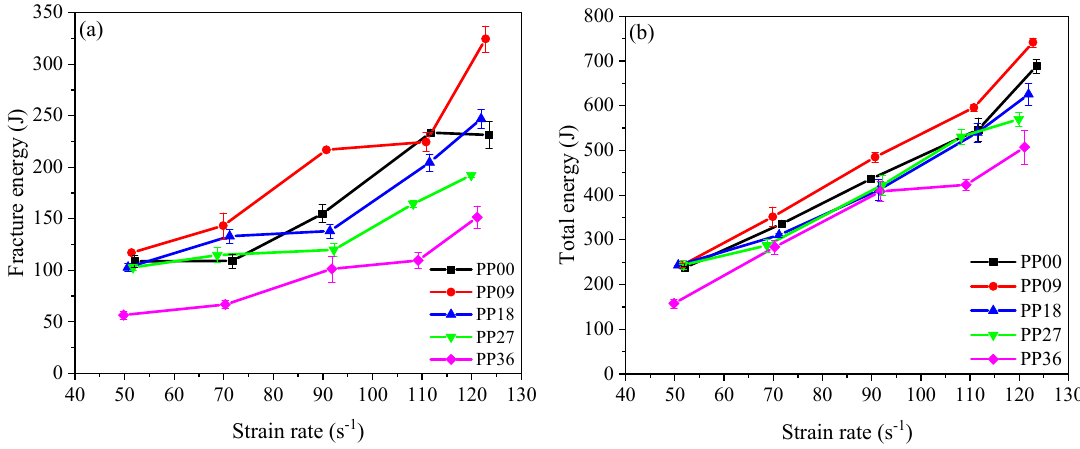
Figure 9. Energy absorption capacity of concrete at different strain rates:( a ) Fracture energy;( b ) Tolal energy.